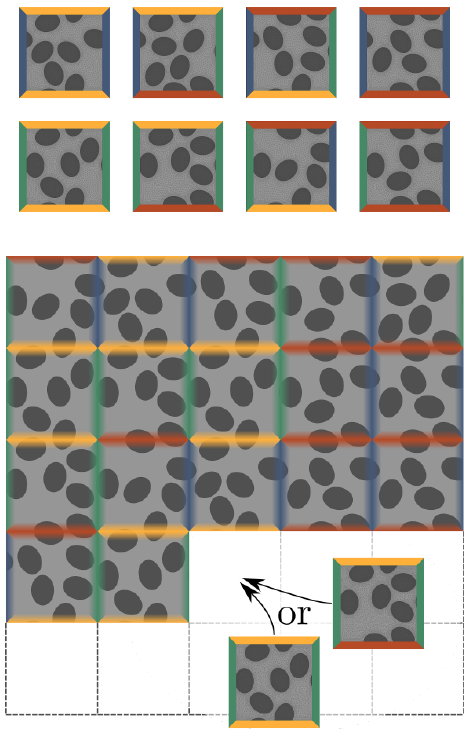
Figure 1. The compressed microstructural geome- try represented with the set of Wang tiles (top) and an illustration of a step in the tiling algorithm with partially assembled microstructure